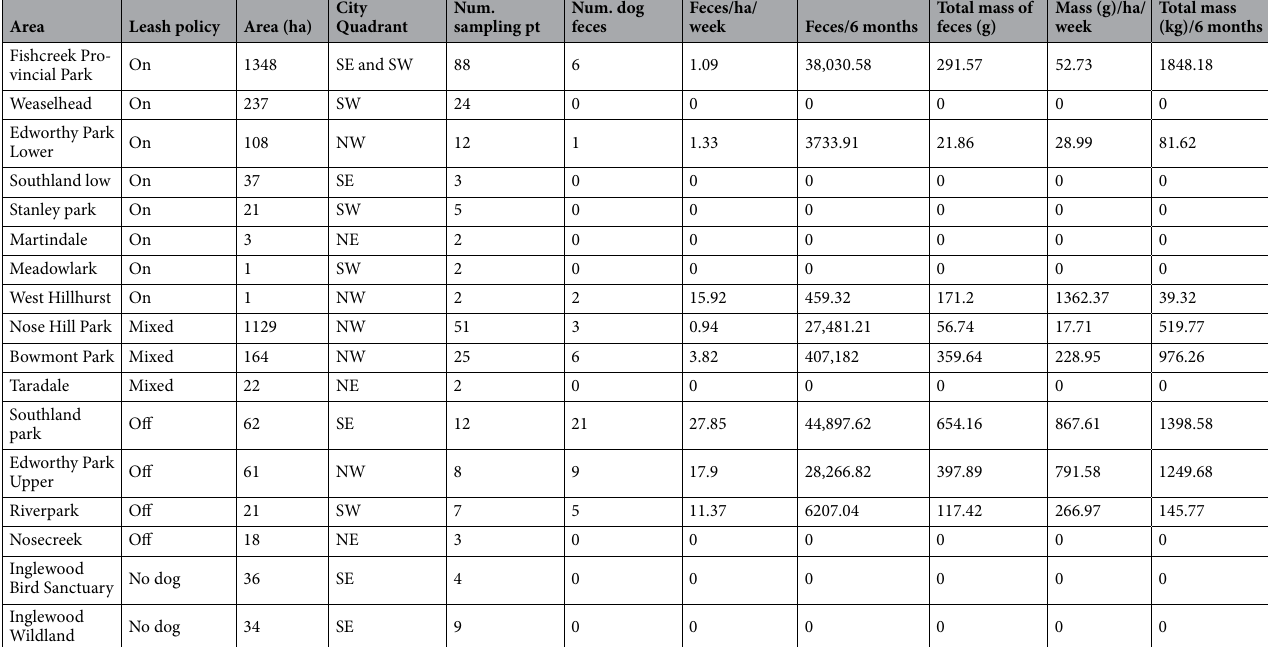
Table 1. Leash policy, area size, city quadrant, and number/mass of dog feces found in each park during a survey from random points within urban parks in the City of Calgary (AB, Canada) in the year 2011. In table are reported the number and mass of feces, average contamination rate per hectare per week, and the total feces estimated for the entire park in 6 months snow-free period.